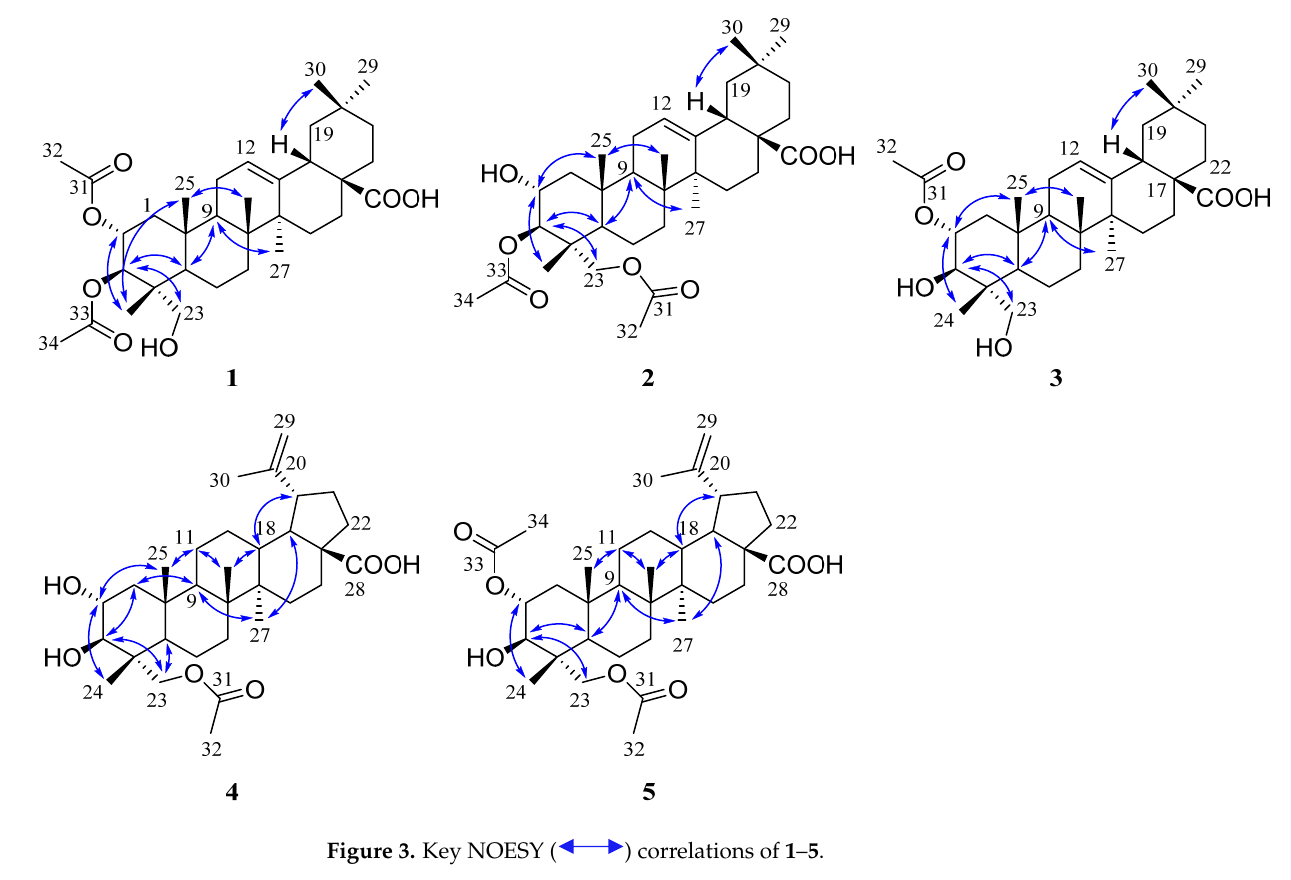
Figure 3. Key NOESY ( ) correlations of 1 – 5 . Table 1. 1 H NMR spectroscopic data of 1 – 6 measured at 600 MHz [ δ H , mult. ( J in